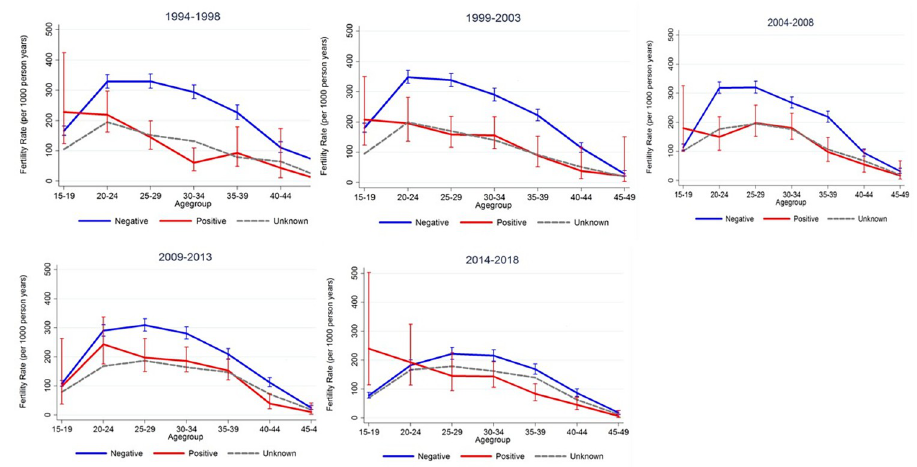
Fig 4. ASFR trends by HIV status. ASFR by HIV Status (1994–1998), ASFR by HIV Status (1999–2003), ASFR by HIV Status (2004–2008), ASFR by HIV Status (2009–2013), ASFR by HIV Status (2014–2018).